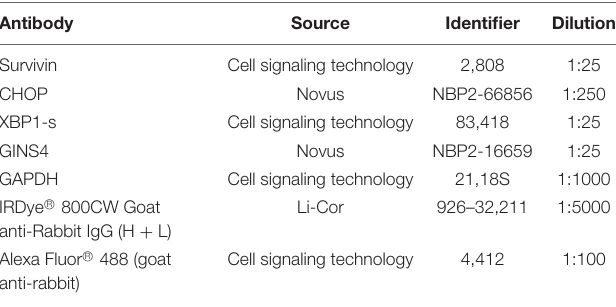
TABLE 2 | Antibodies used in this